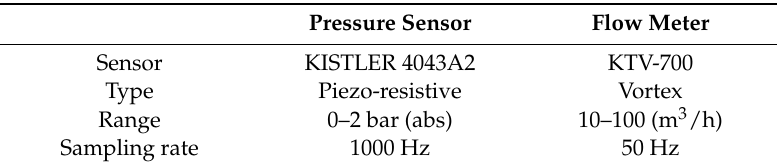
Table 2. Specification of the pressure sensor and flow meter.